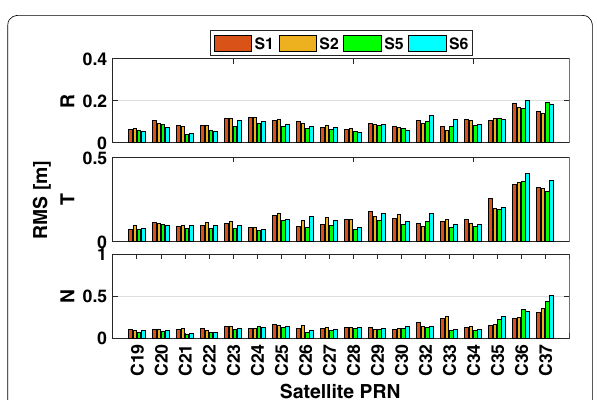
Fig. 10 BDS-3 OBD of each satellite